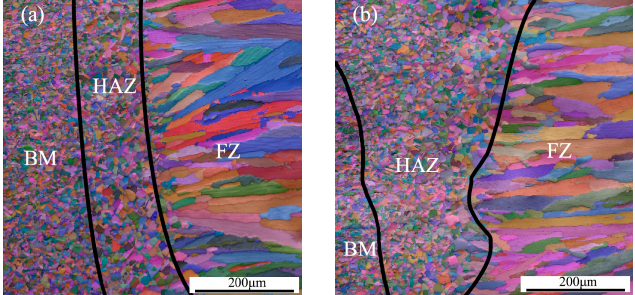
Figure 4. The micrographs of welded joints, including BM, HAZ, and FZ, under different welding speeds: ( a ) 1.5 m/min and ( b ) 2.5 m/min.